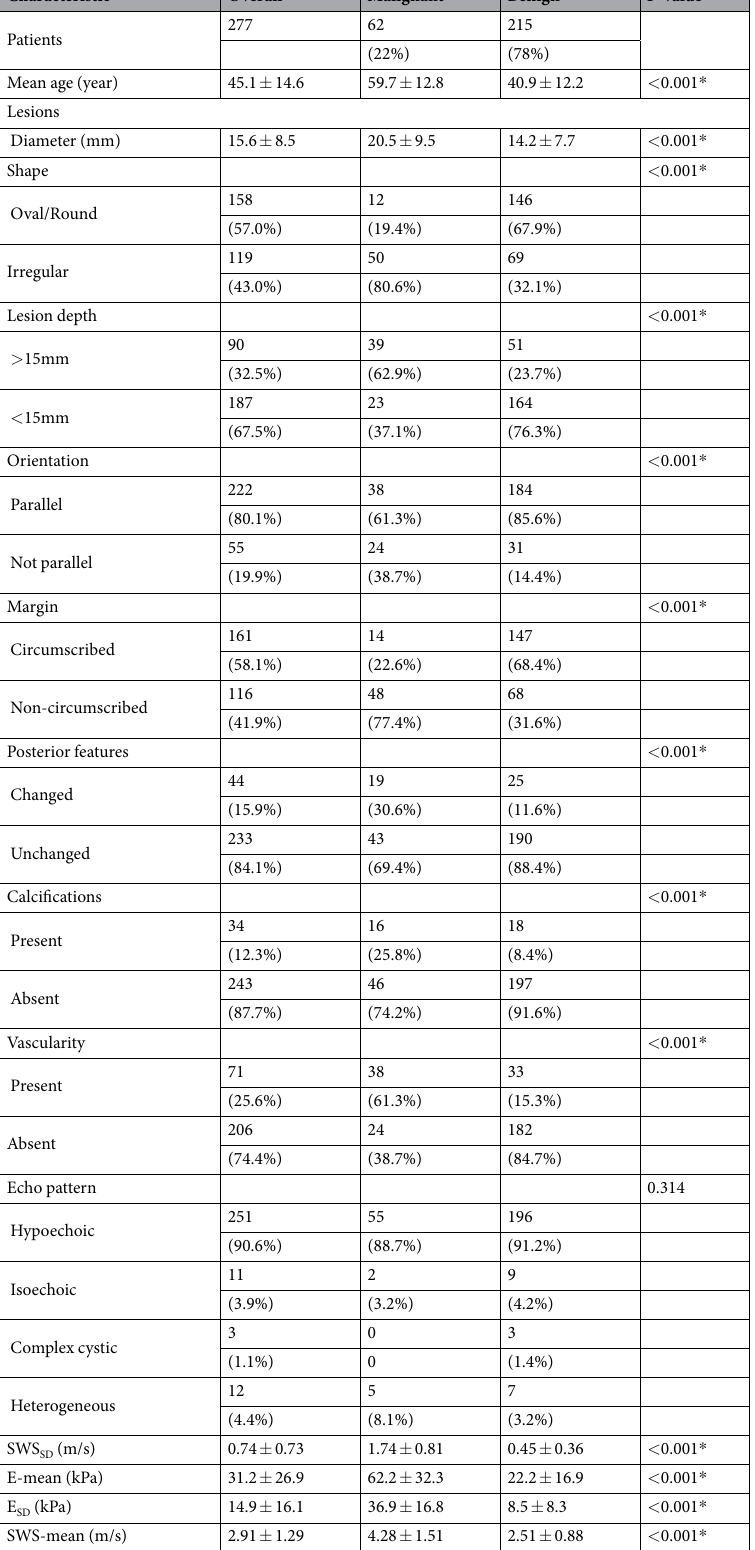
Table 2. Ultrasound and shear wave elastography characteristics of benign and malignant lesions. * Indicates a significant difference. Data are shown as means ± standard deviations; SWS SD = standard deviation of shear wave speed; E-mean = the mean elasticity; E SD = standard deviation of elasticity; SWS-mean = the mean shear wave speed; Changed posterior features include enhancement, shadowing and combined